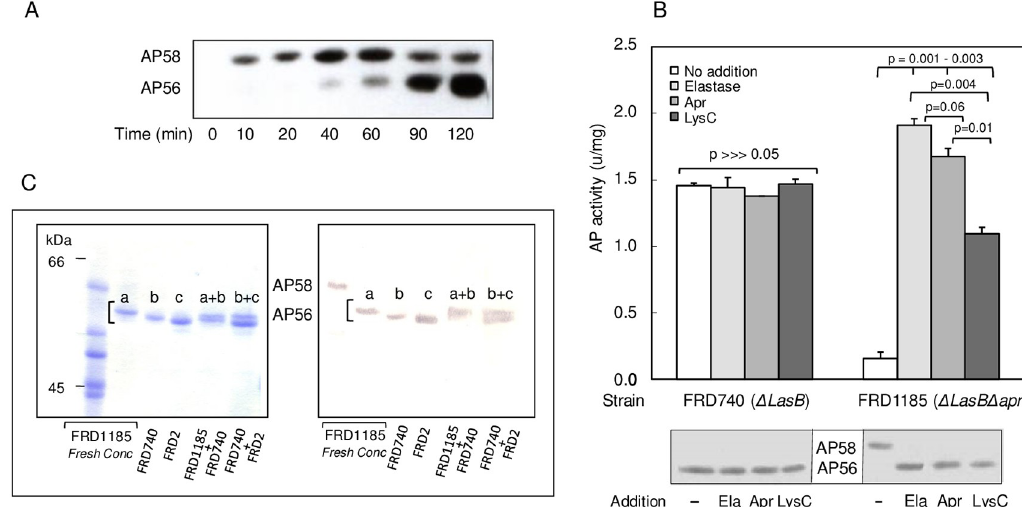
Fig 1. PaAP is secreted as a 58 kDa proenzyme that is processed to distinct active forms of ~56 kDa (AP56 a,b,c) each, depending on the processing protease. A , Progressive processing of AP58 in strain FRD2 (wild type). Bacteria grown to the late logarithmic phase were washed and incubated further in fresh medium for two hours. Samples removed at the indicated times were centrifuged and proteins in the cell-free supernatants were precipitated with trichloroacetic acid (TCA), solubilized in Laemmli’s sample buffer, and analyzed by immunoblotting with an antibody against the catalytic domain (AP28) of PaAP (see Methods). B , Aminopeptidase activity in culture filtrates of strains FRD740 and FRD1185 (Ela - Apr + LysC + and Ela - Apr - LysC + , respectively; 500 μ l, 0.5 μ g PaAP) after incubation (1 h, 37˚C) with/without addition of Ela (0.2 μ g), Apr, or LysC (0.5 μ g each). P values above each bar refer to differences between the columns below as indicated. Bottom Inset , immunoblots of the respective incubation solutions probed with a rabbit antibody to AP28. C , SDS-PAGE (12 cm long 8% gel, Coomassie staining, left panel) and immunoblotting (right panel) of culture filtrate samples from strains FRD1185 (Ela - Apr - LysC + , fresh and concentrated, as indicated), FRD740 (Ela - Apr + LysC + ) and FRD2 (Ela + Apr + LysC + ), showing that AP56 from each strain (designated AP56 a, b, c) migrates differently. FRD1185 + FRD740, mixture of culture filtrates from these strains; FRD740 + FRD2, mixture of culture filtrates from these strains. PaAP related bands in the immunoblot were detected with an alkaline-phosphatase conjugated secondary antibody (see ref. 9 for